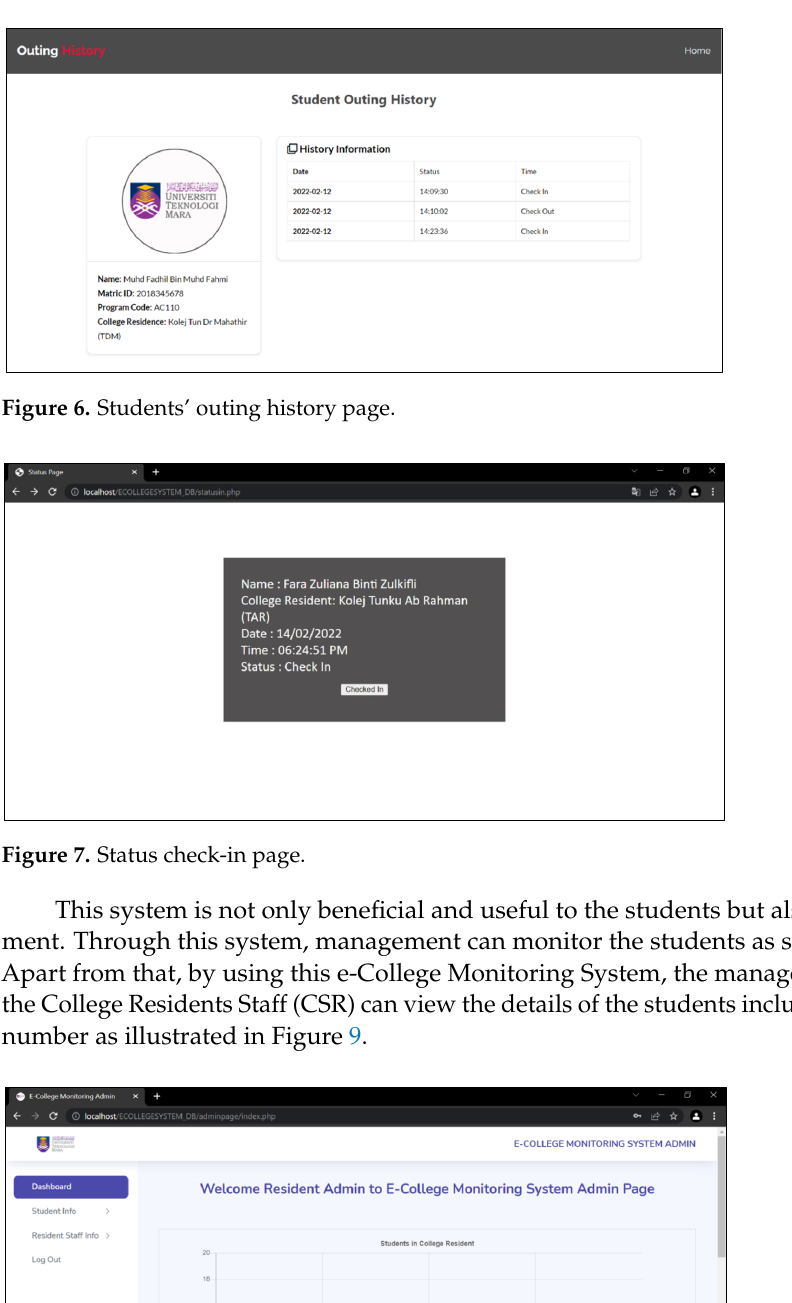
Figure 8. Administrator’s dashboard.